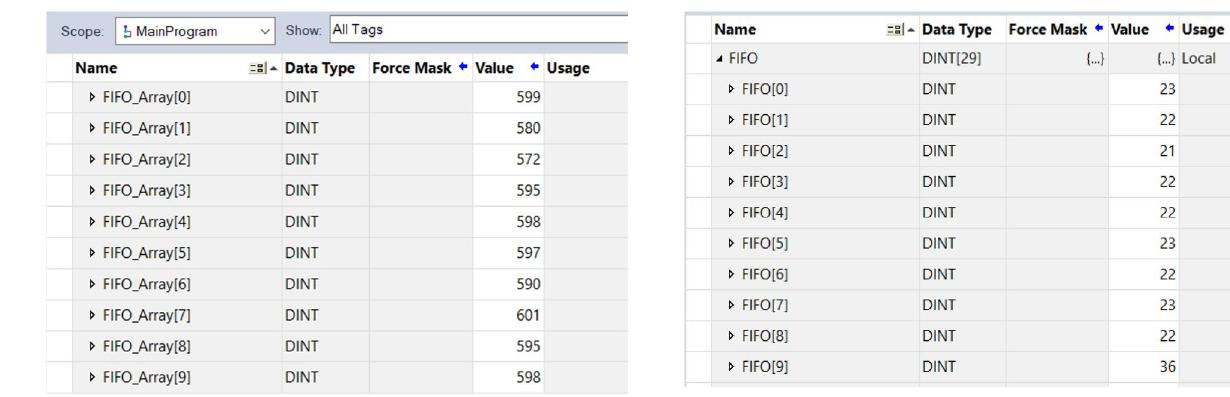
Fig. 18 Capturing scan time values after logic was skipped